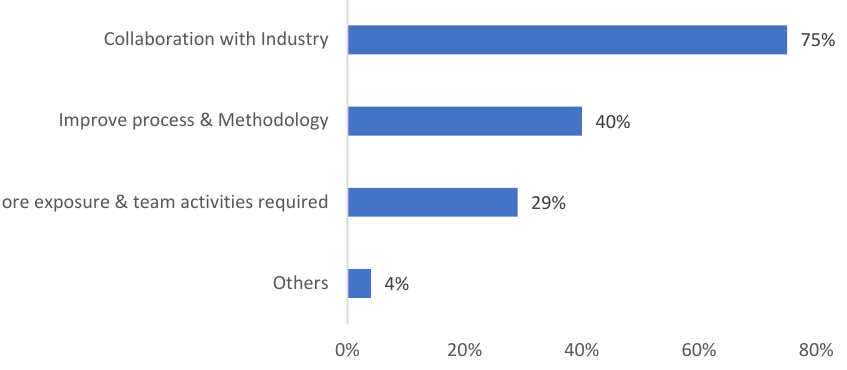
Figure 16. Student responses to the question on ways to improve the N&A module.